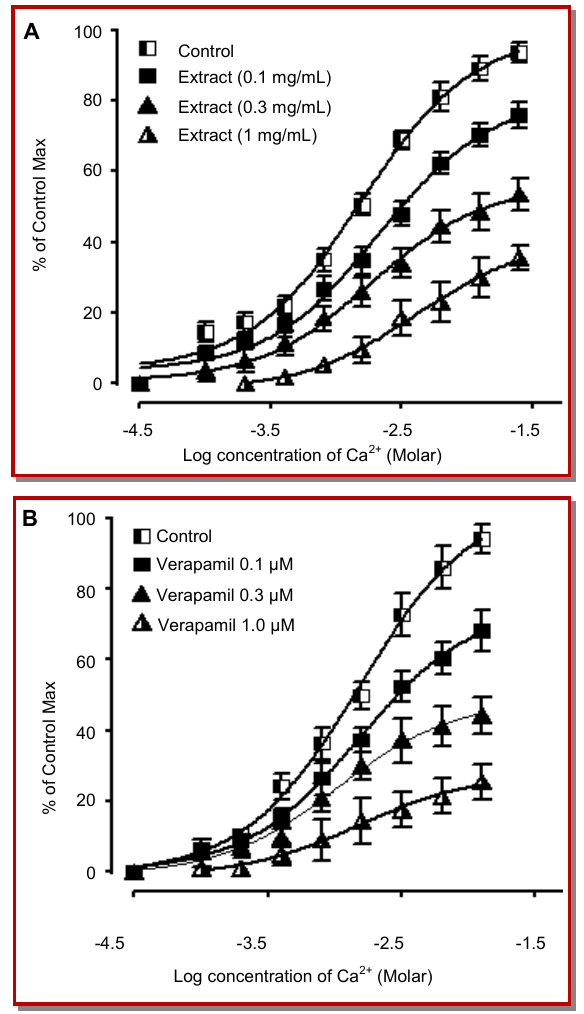
Figure 4: Concentration-response curves of Ca 2+ in the absence and presence of different concentrations of (A) J. gossypifolia and (B) verapamil in isolated rabbit jejunum preparations (values are expressed as mean ± SEM,